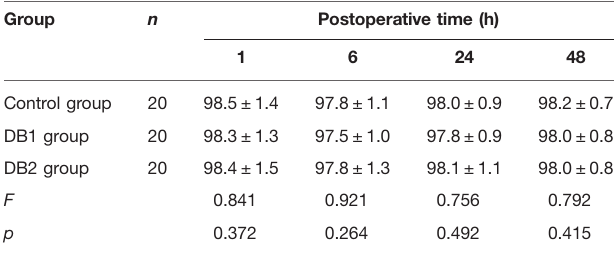
TABLE 5 | Comparison of oxygen saturation of puerperae at different times after surgery among three groups (mean±SD, %). Group